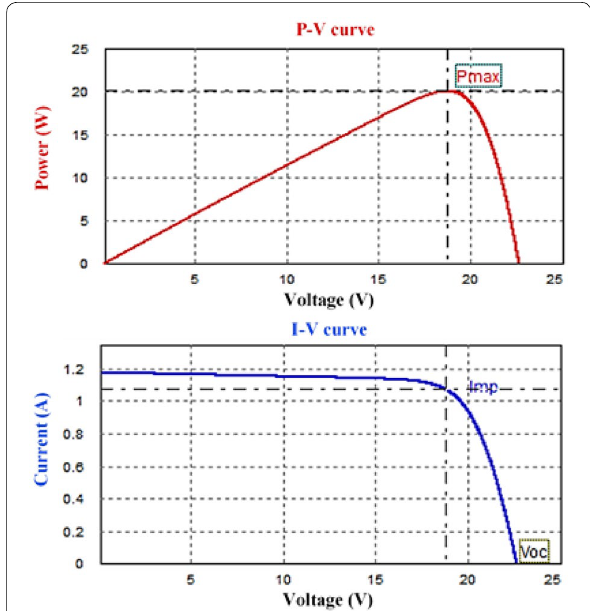
Fig. 3 I – V and P – V characteristics for PV panel under PSIM at STC ( T 25 °C and G 1000 W/m 2 ) = =